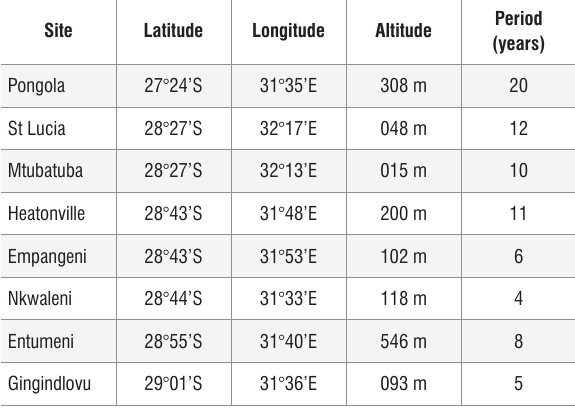
Regional map of KwaZulu-Natal showing Gingindlovu at the highest latitude and Pongola at the lowest and the positions of the eight weather stations. Sites, their global locations and their period of data